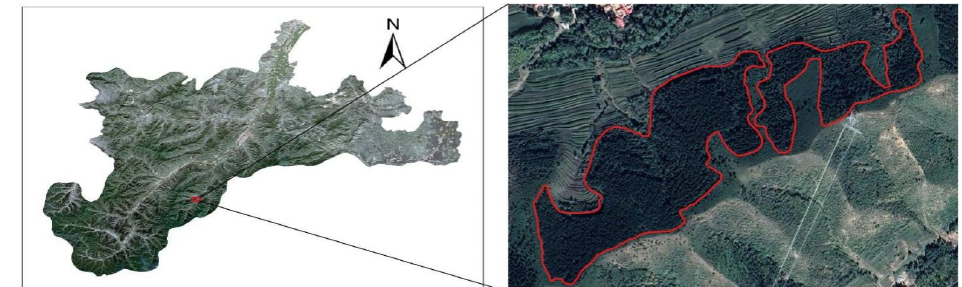
Figure 4. Enlarged view of study area for B4.